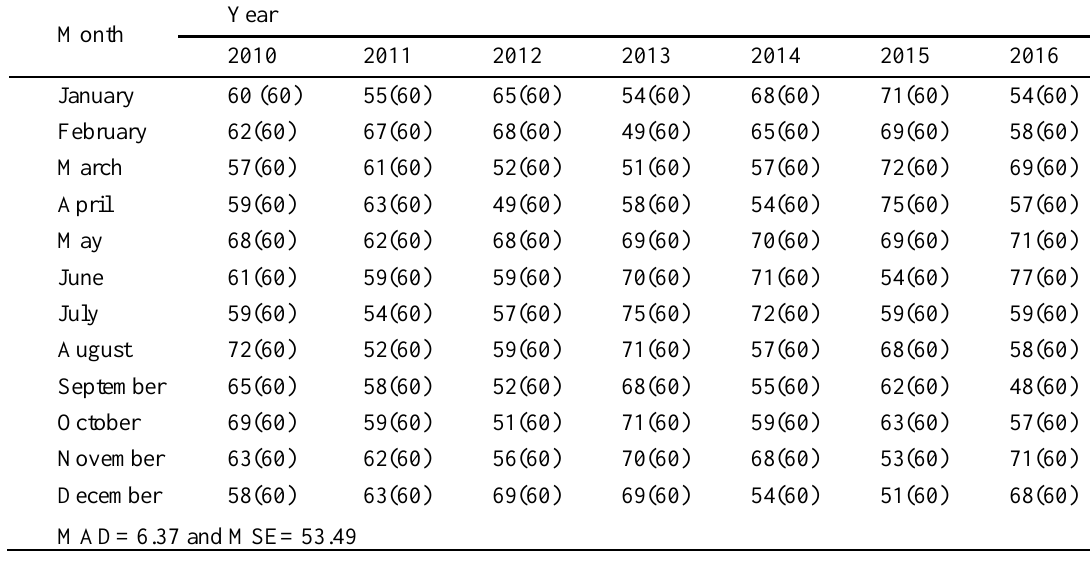
Table 4. Actual and forecasted values for α=0.